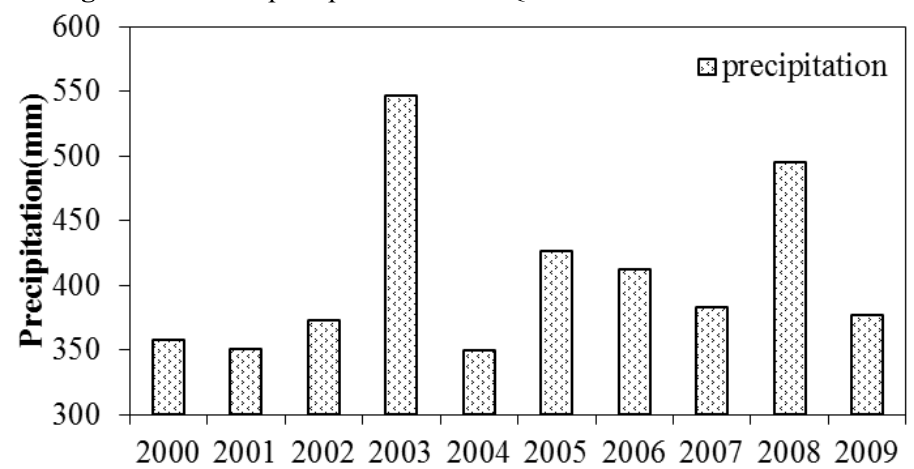
Figure 7. Annual precipitation of the Qilian station from 2000 to